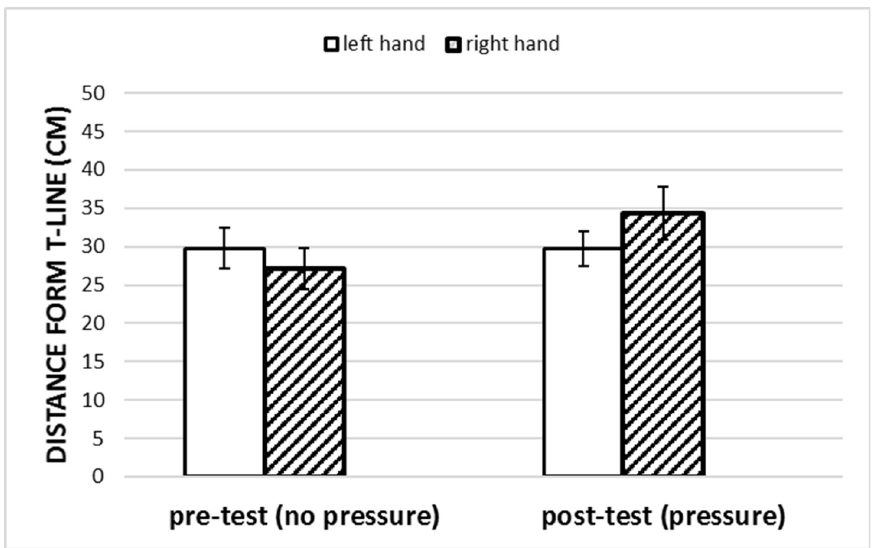
Fig 3. Interaction of phase and group on mean distance of valid serves from target of both groups pre- and post- test. Error bars represent standard errors.